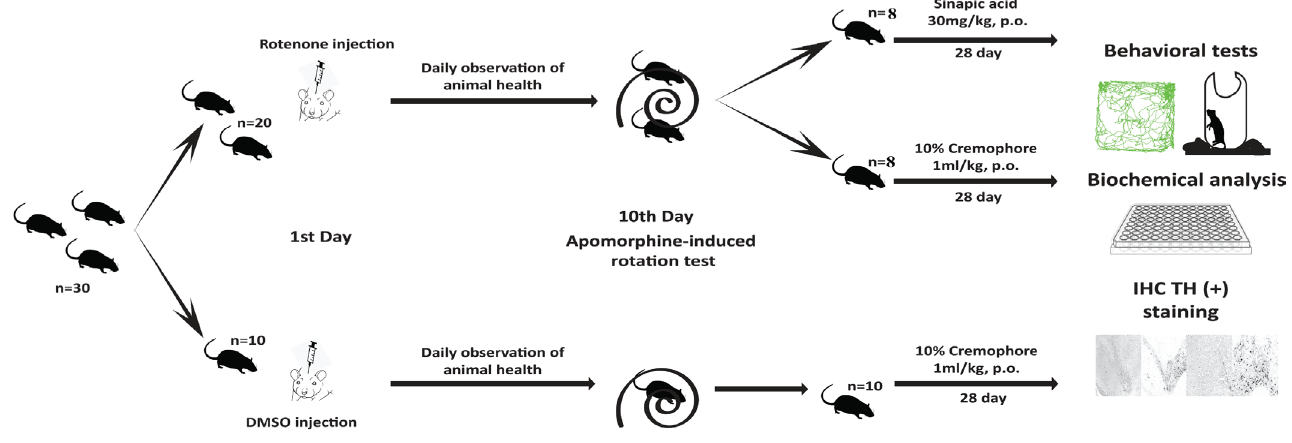
FIGURE 1 - Schematic illustration of the experimental timeline. The number of animals used in each group was represented by the “n”